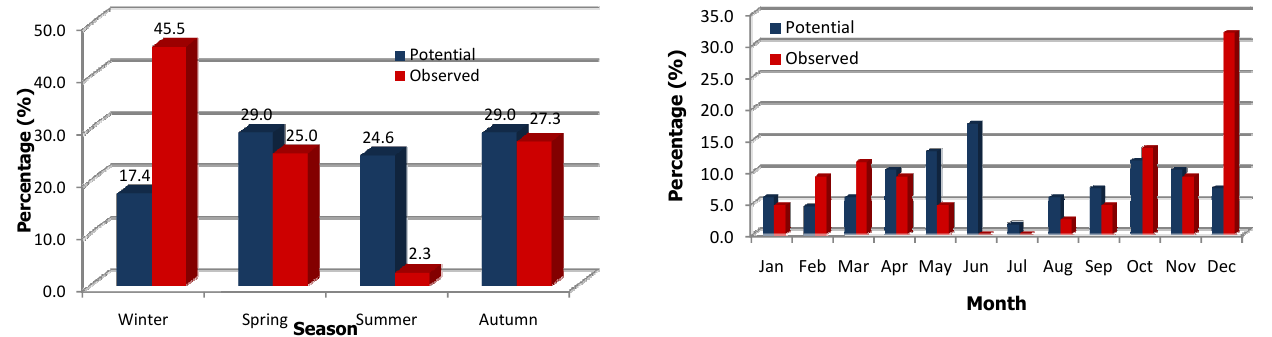
Fig. 9. Seasonal distribution of the potentially and observed ex- treme weather cases.